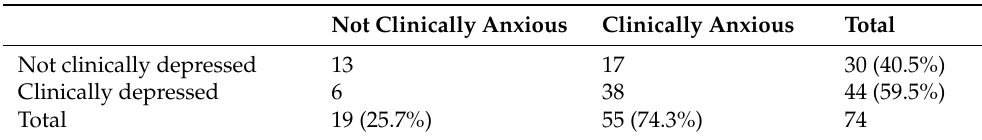
Table 2. Table of observed frequencies of clinical depression diagnosis groups by clinical anxiety diagnosis groups.